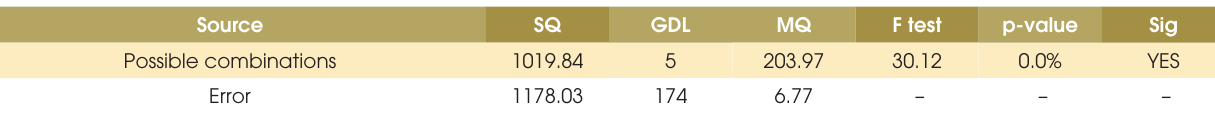
Table 4 – Analysis of variance (ANOVA) of all the possible tying combinations versus cover